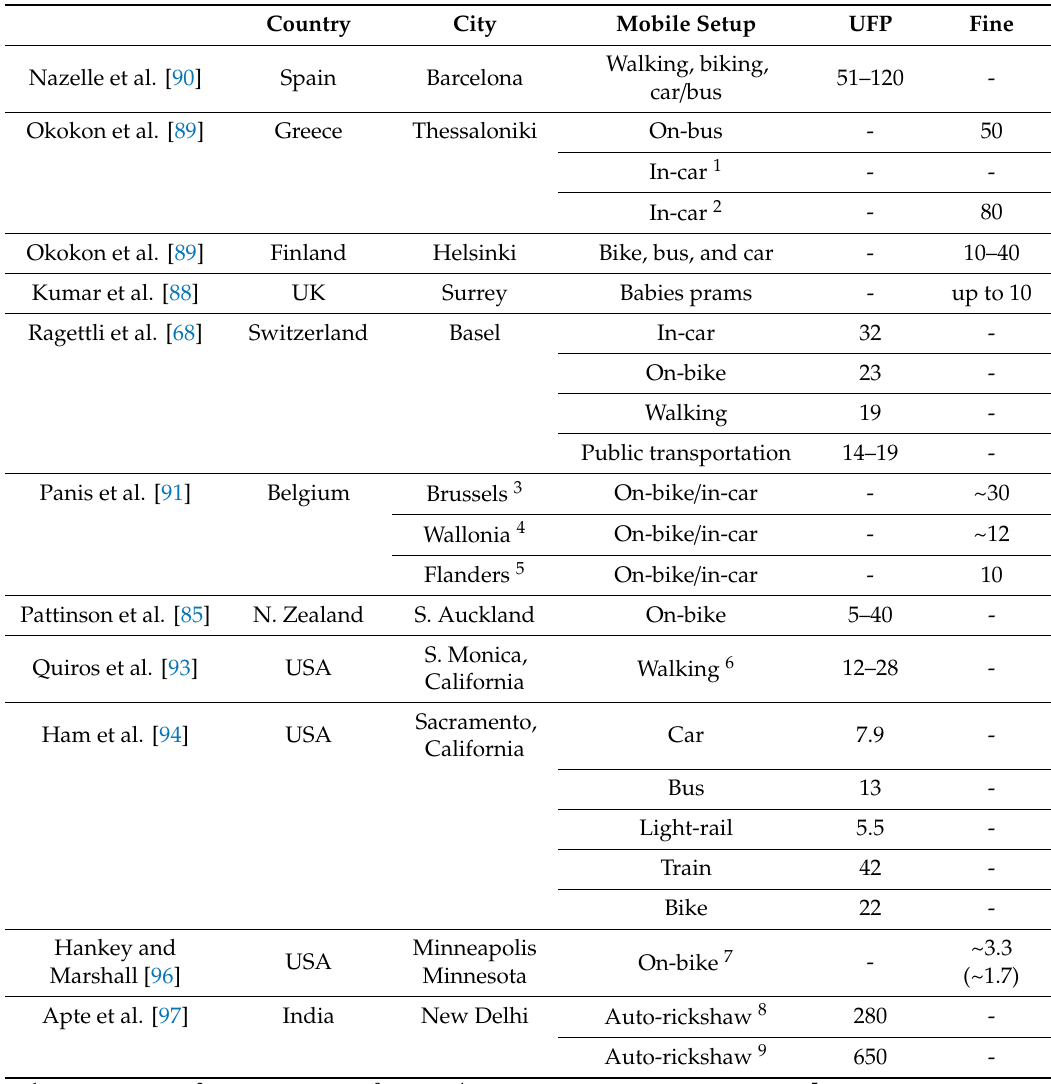
Table 3. Summary of selected literature about mobile measurements of particle number concentrations ( × 10 3 cm − 3